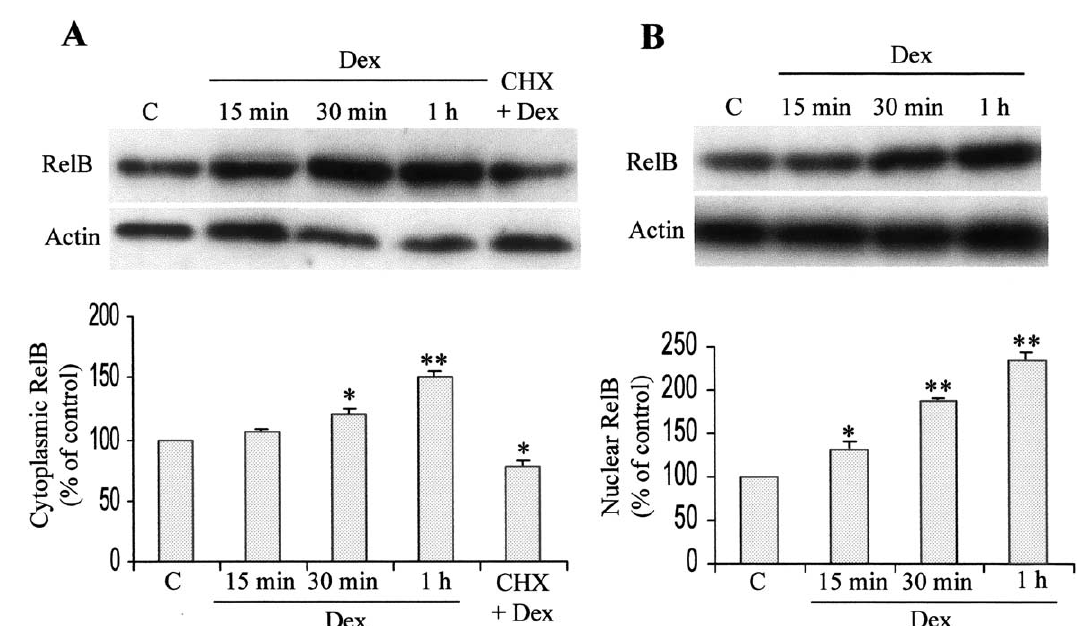
FIG. 4. Dex induces the translocation of the NF- k B protein RelB from the cytoplasm to the nucleus. CCRF-CEM cells were treated with Dex (1 m M), for the indicated periods, in the absence or in the presence of CHX (20 m g/ml) for 1 h. The cytoplasmic and nuclear extracts were prepared, as described in Materials and methods. The RelB cytoplasmic (A) and nuclear (B) content were determined by western blot analysis, using a rabbit polyclonal anti-RelB antibody, and the bands were quantified with an image analyser. The results presented in the upper panels are representative of four independent experiments. The data shown in the lower panels are the average 9 / SD of four independent experiments. * p B / 0.05 and ** p B / 0.01, as determined by one-way analysis of variance with Dunnett’s post